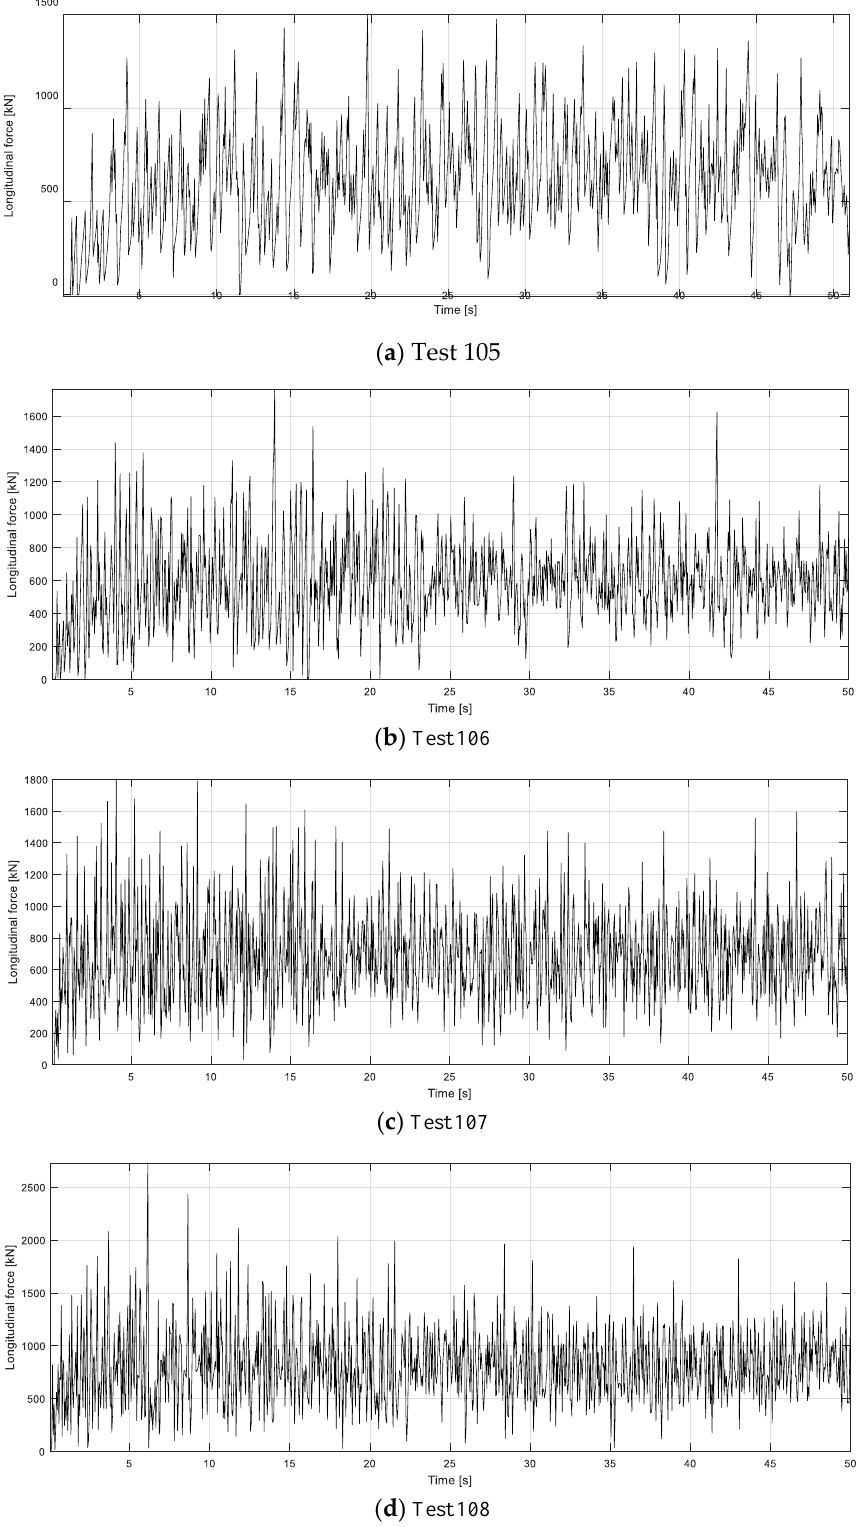
Figure 9. Simulated ice load for ( a ) test 105, ( b ) test 106, ( c ) test 107, and ( d ) test 108 in the time domain. Table 2. Statistics for the simulation and model test data.